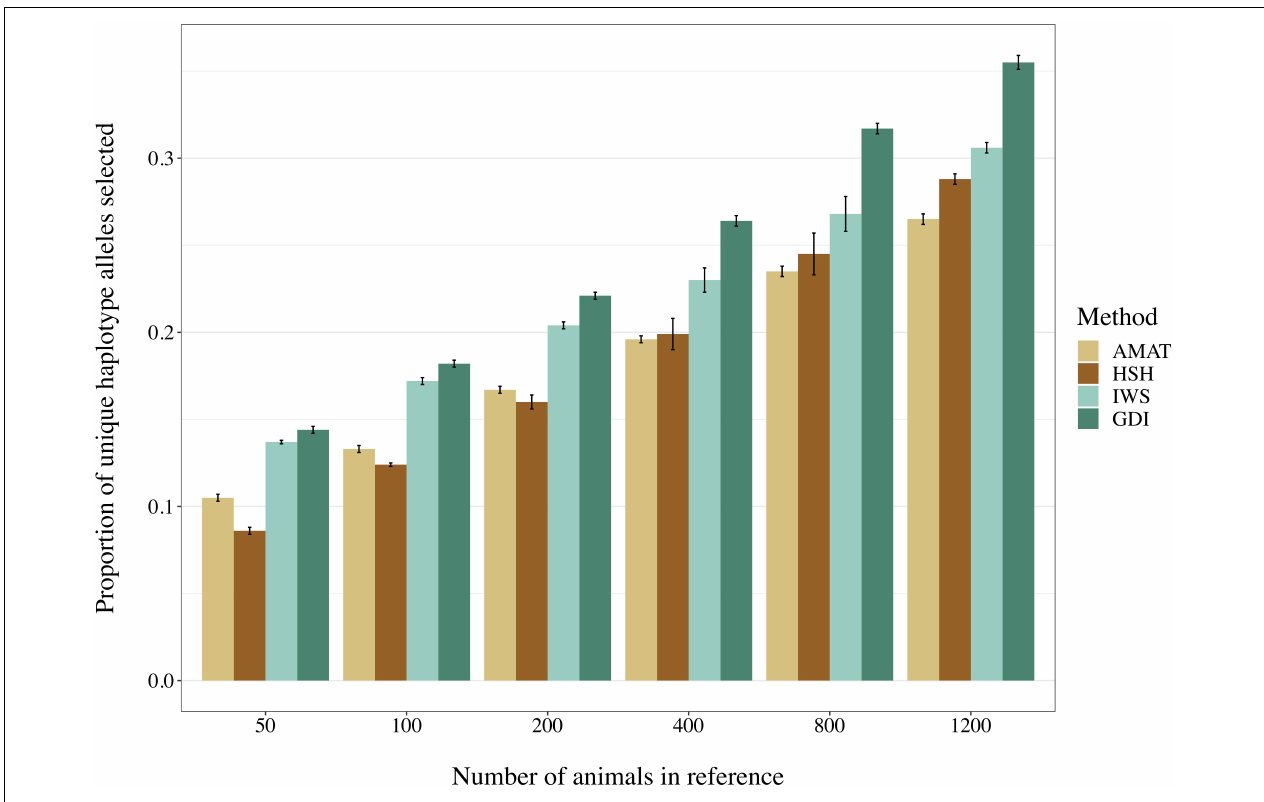
FIGURE 8 | Selected proportion of unique haplotypes from the total haplotype library found in the reference group created with different selection methods. The methods compared are the key ancestors (AMAT), the Highly Segregating Haplotype selection (HSH), the Inverse Weighted Selection (IWS), and the Genetic Diversity Index